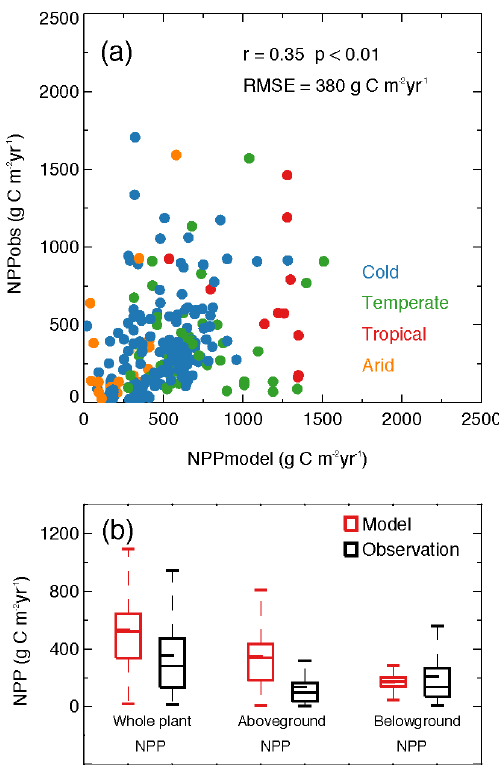
plant NPP (NPP obs ) and modelled NPP (NPP model ) ; (b) box-and- whisker plot of the observed and modelled annual whole-plant NPP, aboveground NPP, and belowground NPP. In subplot (a) , grass- land sites in different Köppen climate zones are specified by dif- ferent colours. The Köppen climate zones are classified based on Peel et al. (2007) using climate data from WorldClim (http://www. worldclim.org/). In subplot (b) , the “whisker” indicates the cross- measurement (total 270 measurements)